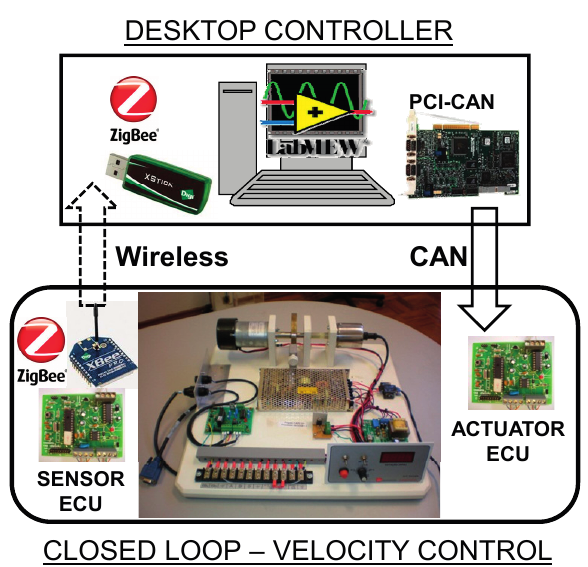
Figure 1. Wireless Networked Control System using CAN and